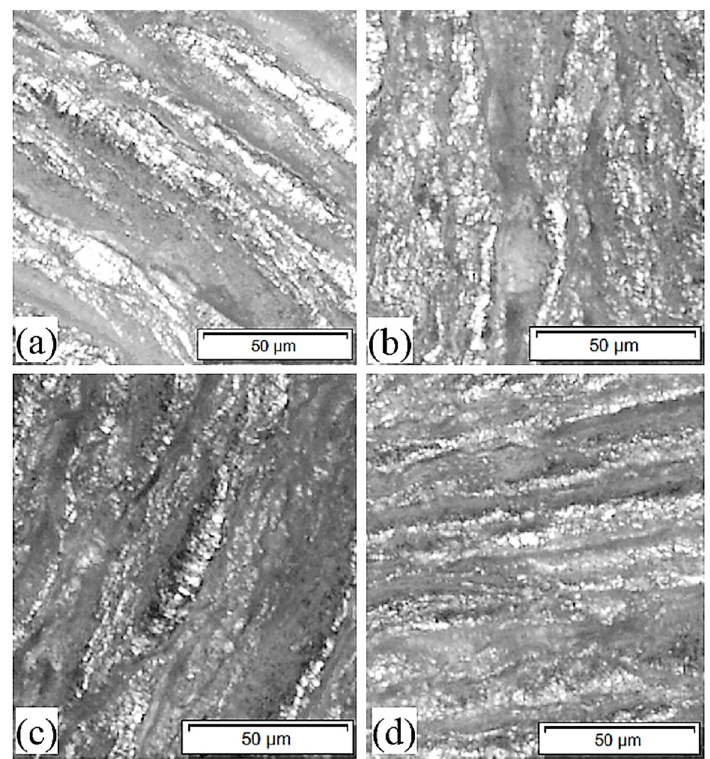
Figure 5. Top surfaces of chips in different conditions: ( a ) 60 mm/min speed, 0.025 mm/tooth feed; ( b ) 60 mm/min speed, 0.075 mm/tooth feed; ( c ) 140 mm/min speed, 0.025 mm/tooth feed and ( d ) 140 mm/min speed, 0.075 mm/tooth feed.